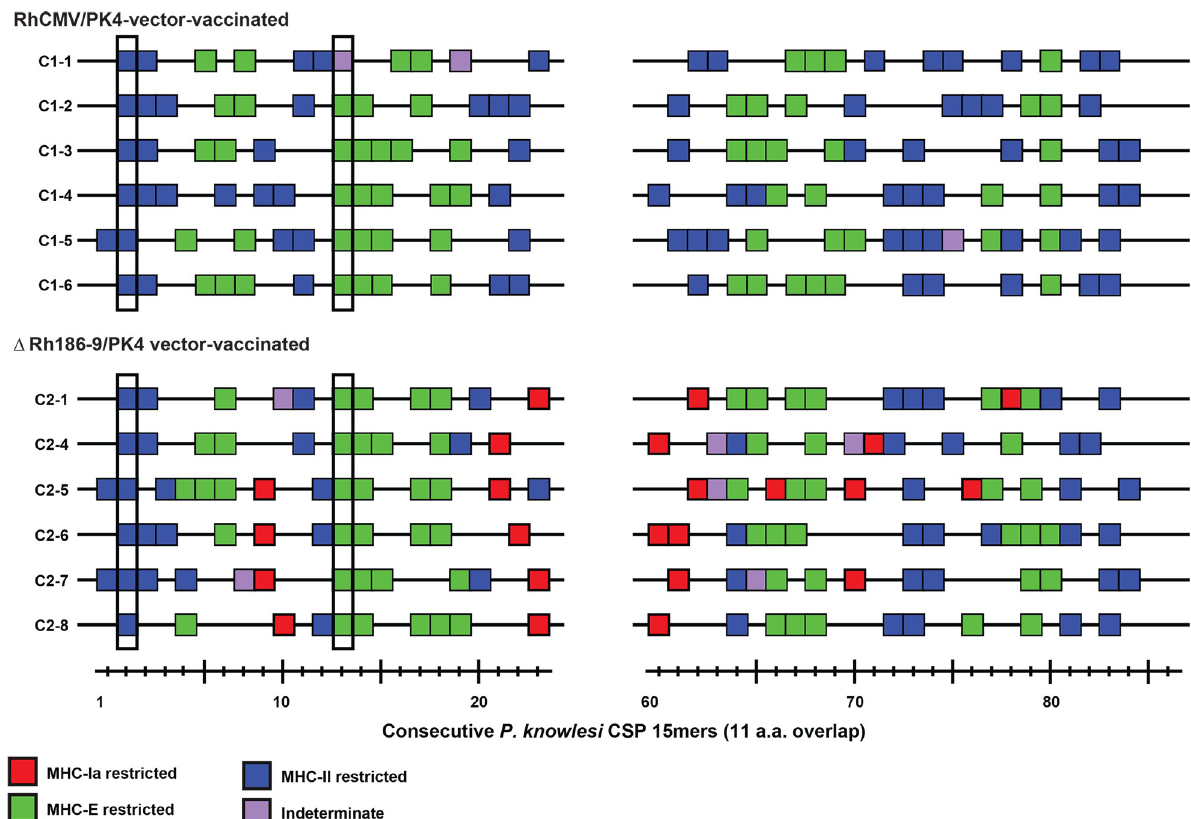
Fig 5. MHC restriction analysis of RhCMV/CSP and Δ Rh186-9/CSP-elicited CD8 + T cell responses. CSP-specific CD8 + T cells were epitope- mapped in six animals of each cohort 1 (upper panel) and 2 (lower panel) using flow cytometric ICS to detect recognition of each consecutive, overlapping 15mer peptide comprising the indicated amino-terminal and carboxy-terminal region of Pk CSP. Peptides resulting in specific CD8 + T cell responses are indicated by a box, with the color of the box designating MHC restriction as determined by blocking with the anti-pan-MHC-I mAb W6/32, the MHC-E blocking peptide VL9 and the MHC-II blocking peptide CLIP as previously described [28, 29]. Highlighted are peptides recognized by T cells in every